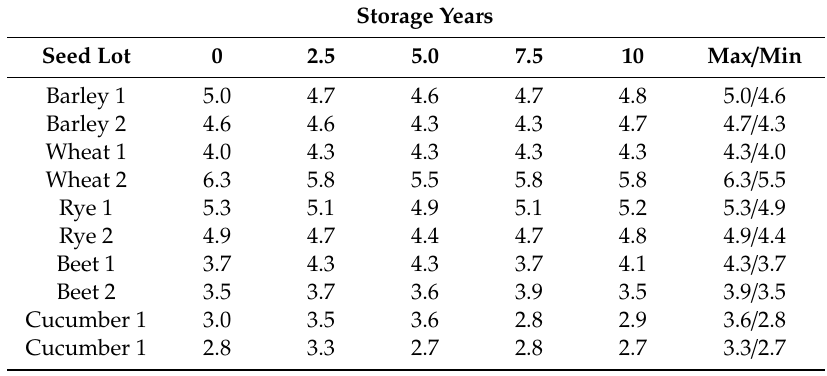
Table 2. Seed moisture content (in %) in the di ff erent lots over the first ten years of the experiment. Storage